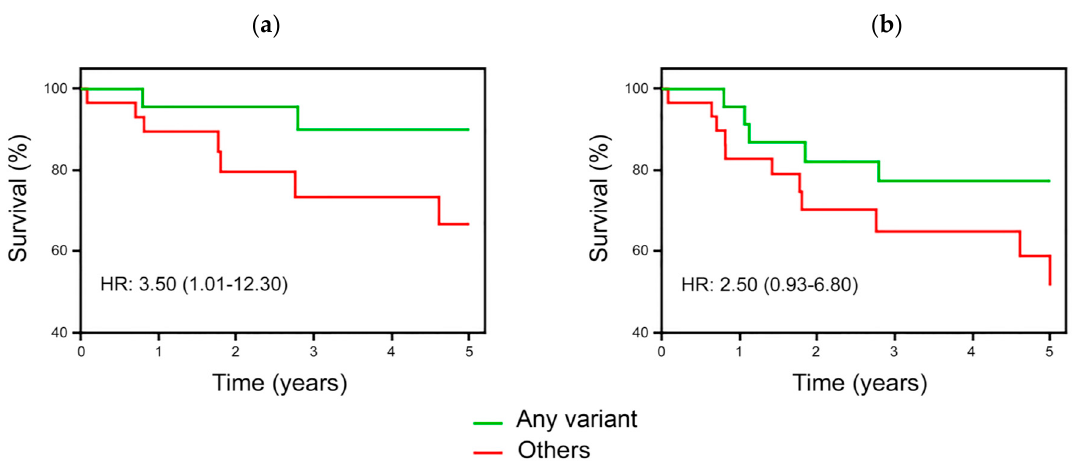
Figure 4. Event-free survival (EFS) among high-risk patients stratified by DHFR / MTHFR 677 gene variant. EFS at 5-years survey in patients carrying DHFR DD- or WD-genotype, and/or MTHFR TT-genotype (Any variant) vs. the remaining patients (Others). Panel ( a ) indicates EFS, as specified in Methods section; Panel ( b ) indicates EFS including prednisone response. The inclusion of the MTHFR A1298C variant, or its coupling with DHFR ins/del variant, did not modify survival analysis.